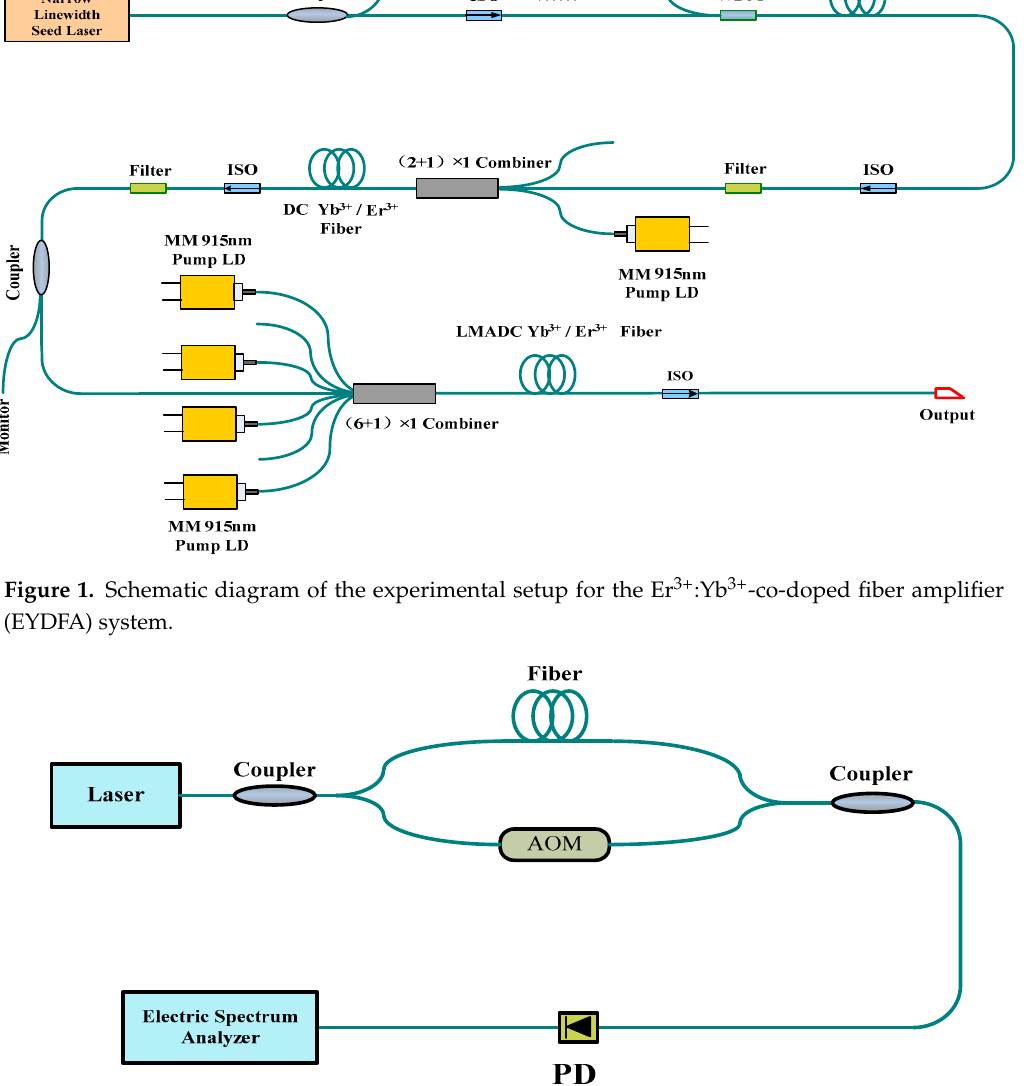
Figure 2. The diagram of the linewidth measurement system.